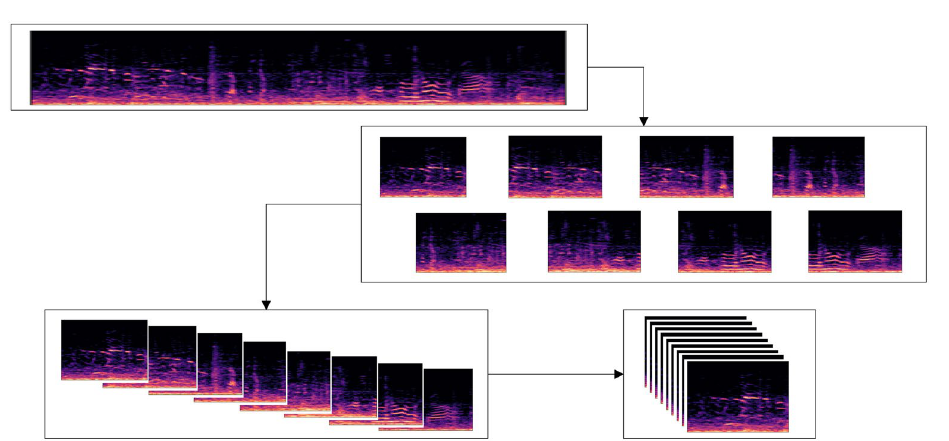
Figure 7. Construction of 3D Feature Maps at the input to the model.